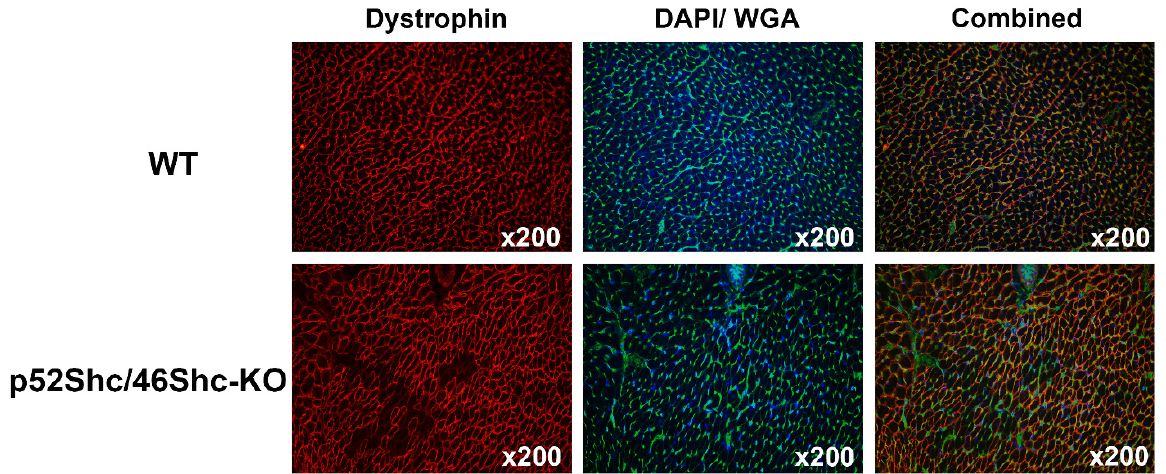
Figure 6. Analysis of cardiac muscle of p52Shc/p46Shc-KO rats and WT littermates. Cross-sections of heart were stained with anti-dystrophin antibody (red staining) and wheat germ agglutinin (WGA)-fluorescein (green staining). DAPI (blue staining) was used to visualize nuclei. Combined images have dystrophin, WGA-fluorescein and DAPI staining. Note large areas that are missing dystrophin staining in the heart section of p52Shc/p46Shc-KO rat.